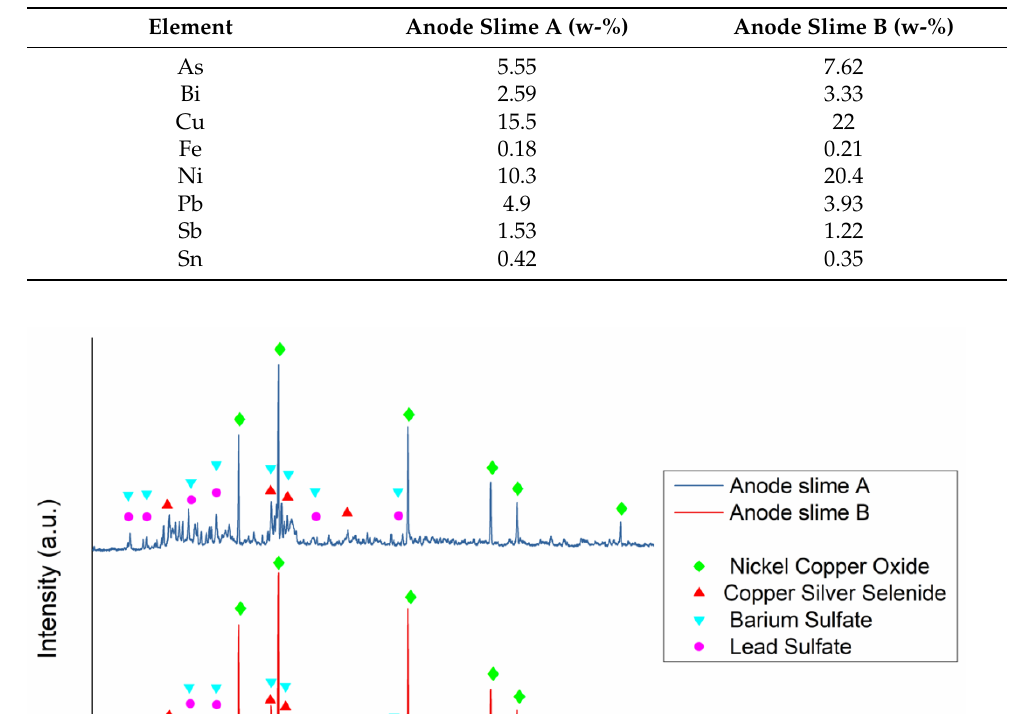
Table 1. Composition of the industrial anode slimes.